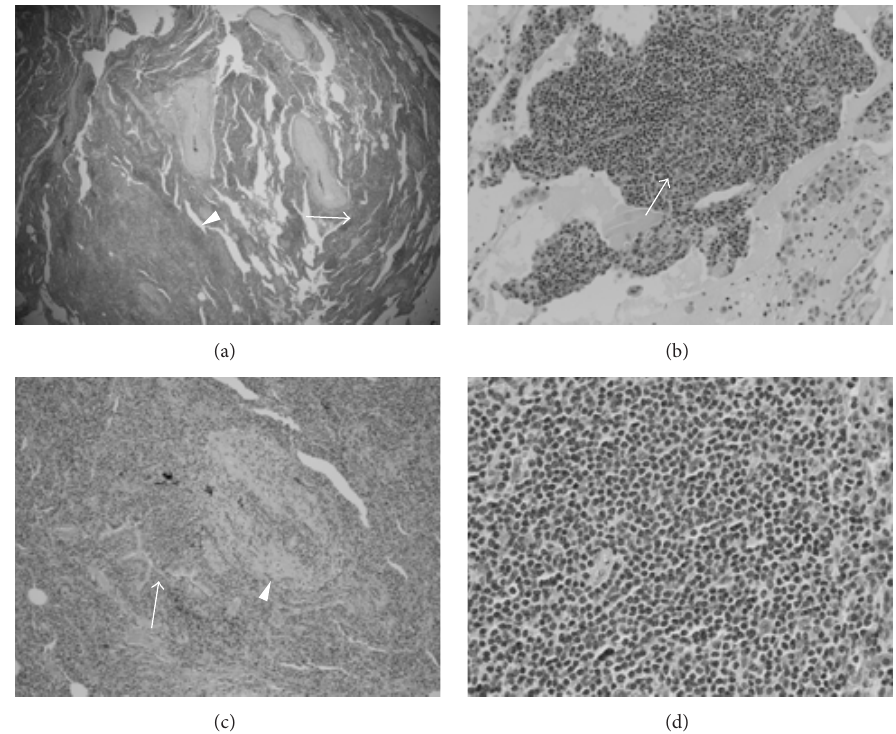
Figure 2: (a) Hematoxylin and eosin-stained lung wedge biopsy showing nodular and interstitial lymphoid infiltrates. Nodule (arrow head) interstitial infiltrate (arrow) (original magnification × 20). (b) Hematoxylin and eosin-stained lung wedge biopsy showing benign germinal centre (arrow) (original magnification × 1000). (c) Hematoxylin and eosin-stained lung wedge biopsy showing atypical lymphoplasmacytic infiltrate around bronchovascular bundle, around blood vessel (arrow head), and around bronchioles (arrow) (original magnification × 100). (d) Hematoxylin and eosin-stained lung wedge biopsy showing atypical small lymphoid cells within the nodular infiltrate (original magnification ×